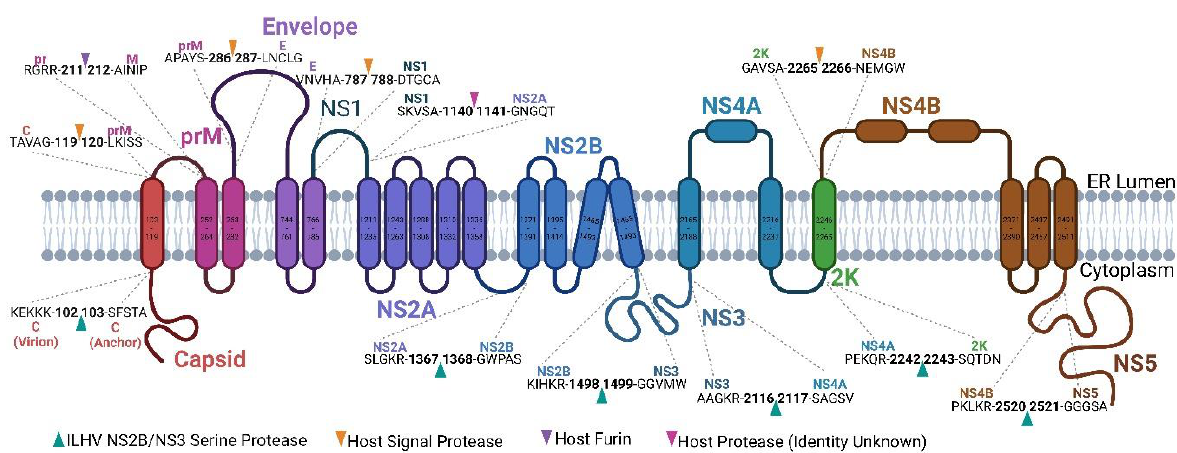
Figure 6. Structure and cleavage of ILHV polyprotein. Schematic map of the ILHV polyprotein. Proteins, putative protein cleavage sites and the corresponding proteases, and transmembrane domains are annotated. Amino acid numbering corresponds to the position in ILHV Original.